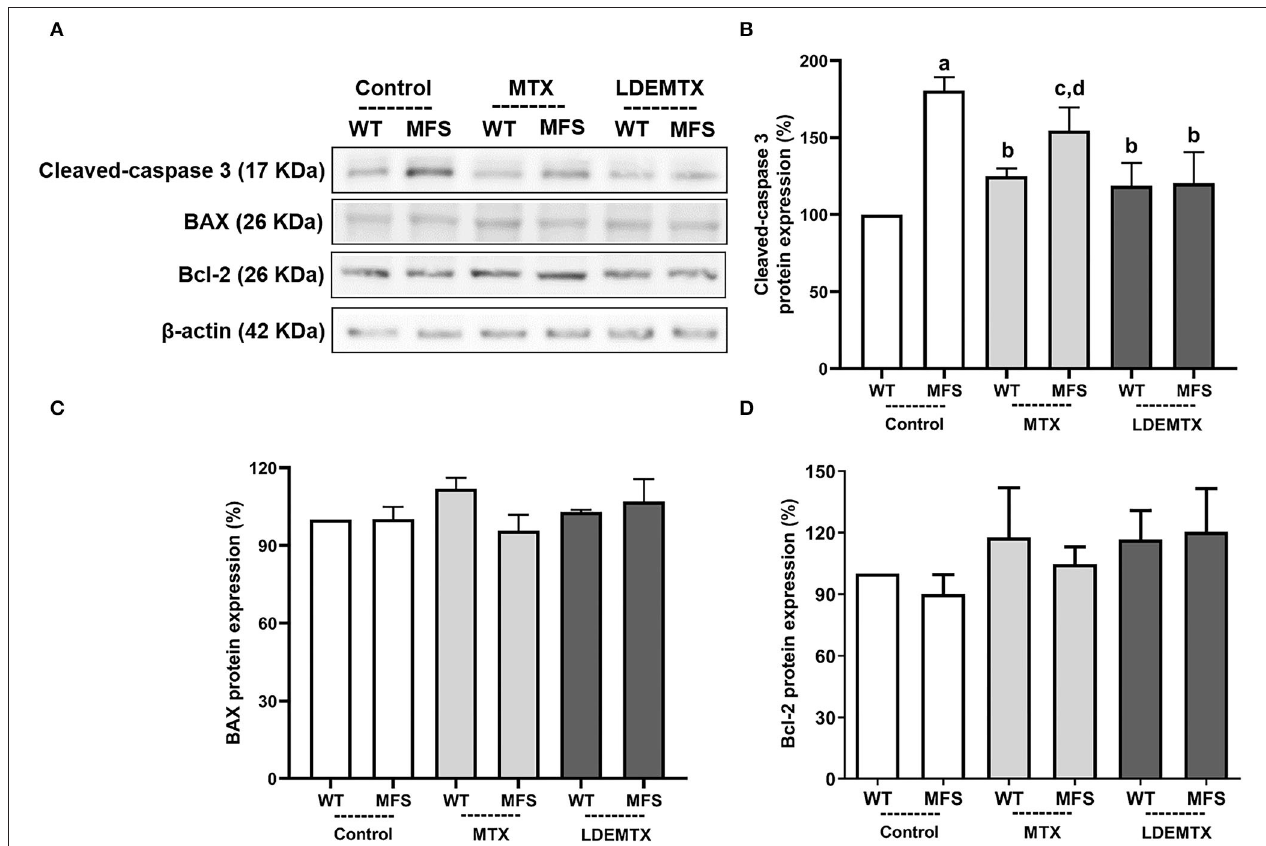
FIGURE 2 | Representative bands (A) and graphs showing western blot analysis of pro-apoptosis cleaved-caspase 3 (B) and Bcl-2 associated X protein (BAX) (C) and anti-apoptosis Bcl-2 (D) protein expression in WT and MFS mice at 6 months of age, treated with MTX and LDEMTX. Values were normalized for expression of β -actin and results were expressed as a percentage of WT-control group means. Data are means ± SEM of a pool of aorta segments, comprising ascending aorta, aortic arch, and descending aorta ( n = 4, per group). (a) p < 0.01 vs. WT-control; (b) p < 0.05 vs. MFS-control; (c) p < 0.05 vs. WT-control; and (d) p < 0.05 vs. WT-MTX.